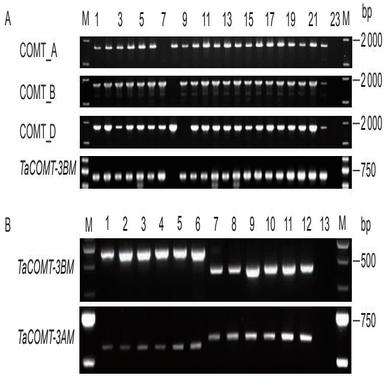
hromosome locations and allelic variations of TaCOMT genes. A, chromosome specificity of primer sets COMT_A, COMT_B, COMT_D, and marker TaCOMT-3BM. M indicates DNA ladder DL2000; 1 to 23 indicate the Chinese Spring (CS) nulli-tetrasomic lines N1A-T1D, N1B-T1D, N1D-T1B, N2A-T2D, N2B-T2A, N2D-T2A, N3A-T3D, N3B-T3D, N3D-T3B, N4A-T4D, M4B-T4D, N4D-T4B, N5A-T5D, N5B-T5A, N5D-T5A, N6A-T6B, N6B-T6A, N6D-T6B, N7A-T7D, N7B-T7D, N7D-T7A, CS, and H2 O, respectively. B, allelic variations of TaCOMT genes tested with